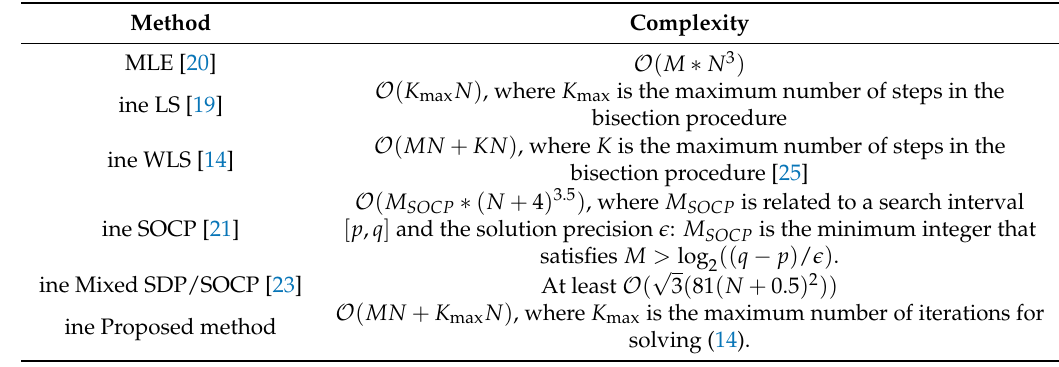
Table 1. Complexity of different